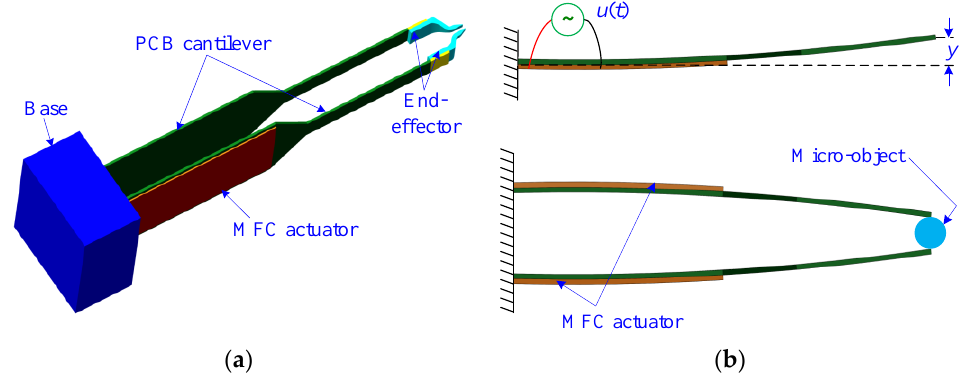
Figure 2. ( a ) Schematic diagram of the MFC microgripper; ( b ) Illustration of a micro-object gripping with a microgripper that contains a pair of MFC actuators.